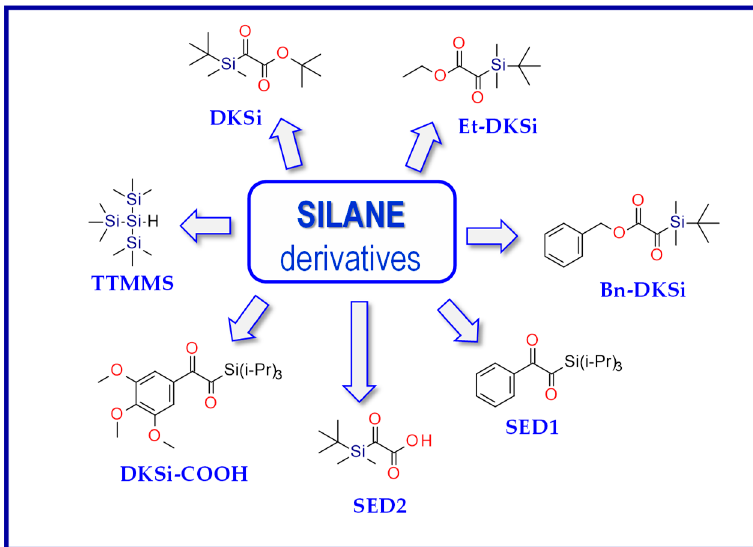
Figure 19. Chemical structures of the silane derivatives: TTMMS—tris (trimethylsilyl) silane; DKSi—tert-butyl (tert-butyldimethylsilyl) glyoxylate; Et-DKSi—ethyl (tert-butyldimethyl)silyl glyoxylate; Bn-DKSi—benzyl (tert-butyldimethyl)silyl glyoxylate; SED1—1-phenyl-2- (triisopropylsilyl)ethane-1,2-dione;SED2—1-(3,4,5-trimethoxyphenyl)-2-(triisopropylsilyl)ethane- 1,2-dione; DKSi-COOH—2-oxo-2(tert-butyldimethylsilyl) acetic acid.